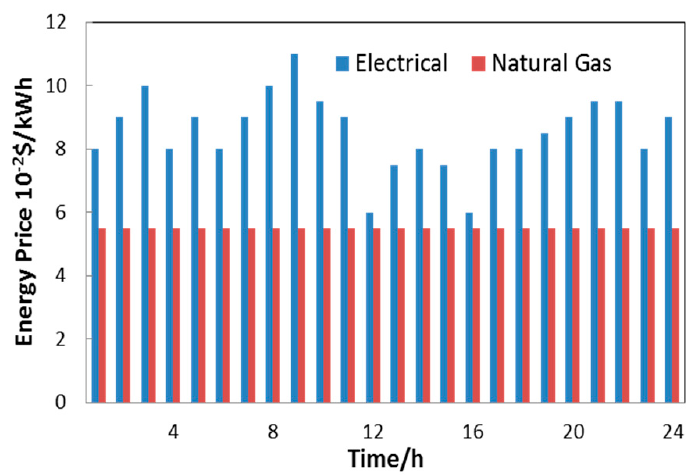
Figure 7. Electricity and gas spot-prices.